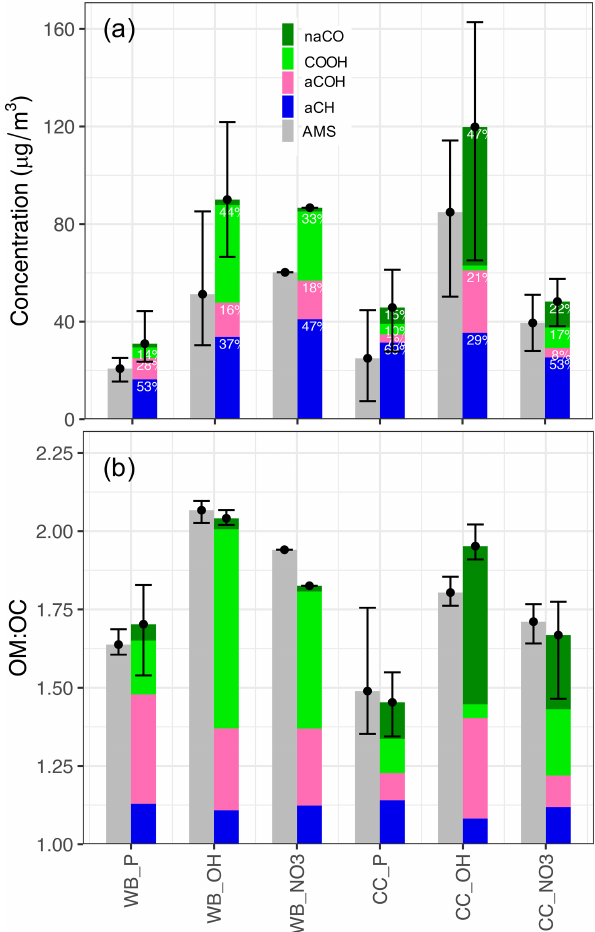
Figure 1. (a) Bar plot of averaged MIR (separated by functional group) and AMS OA concentration estimates without wall-loss cor- rection. The contribution of each functional group (with contribu- tion > 5%) to total OA, the type of aerosol (P: primary), emission source (WB and CC), and oxidant used for aging (OH: hydroxyl radical, NO 3 : nitrate radical) are indicated for each category. (b) Bar plot of averaged MIR and AMS OM : OC estimates separated by the contribution of each functional group. The error bars show the max- imum and minimum concentrations and OM : OC values for each category. For the estimates of each individual experiment refer to Fig.